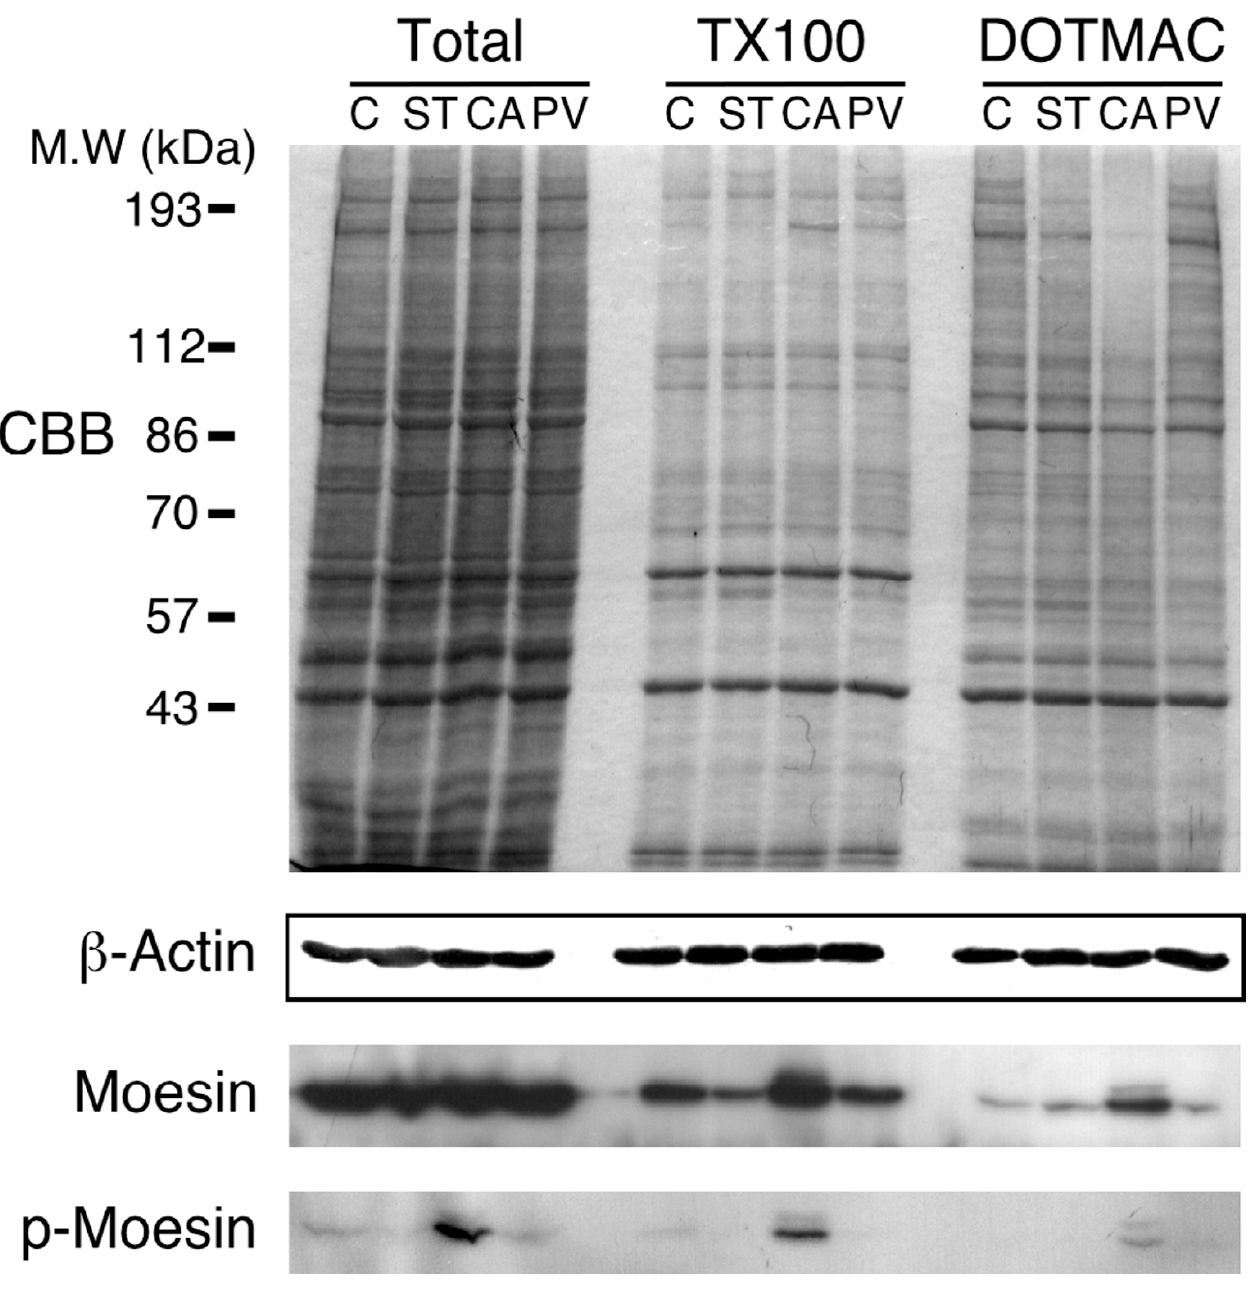
Figure 7 Determination of detergent-resistant components of NIH3T3 cells before (C) and after treatment with kinase, staurosporine (ST), or phosphatase inhibitors, calyculin A (CA) or pervanadate (PV). The subconfluent cells were rinsed with PBS(+), and detached by treating with 0.02% EDTA in PBS. The suspended cells were incubated with or without 1 µ M calyculin A, 1 µ M staurosporine, or 100 µ M pervanadate in PBS(+) for 10 min at 37 ° C. The cells were extracted for 5 min on ice with an equal volume of 2 × detergent extraction buffer containing 2% of Triton X-100 or DOTMAC. The lysates were centrifuged at 15,800 × g for 5 min at 4 ° C. The resulting pellets were solubilized in SDS sample buffer and subjected to SDS- PAGE on a 9% polyacrylamide gel electrophoresed. Polypeptides were stained with Coomassie Brilliant blue (CBB). β -Actin, moesin, and threonine558-phospho-moesin were detected by immunoblot